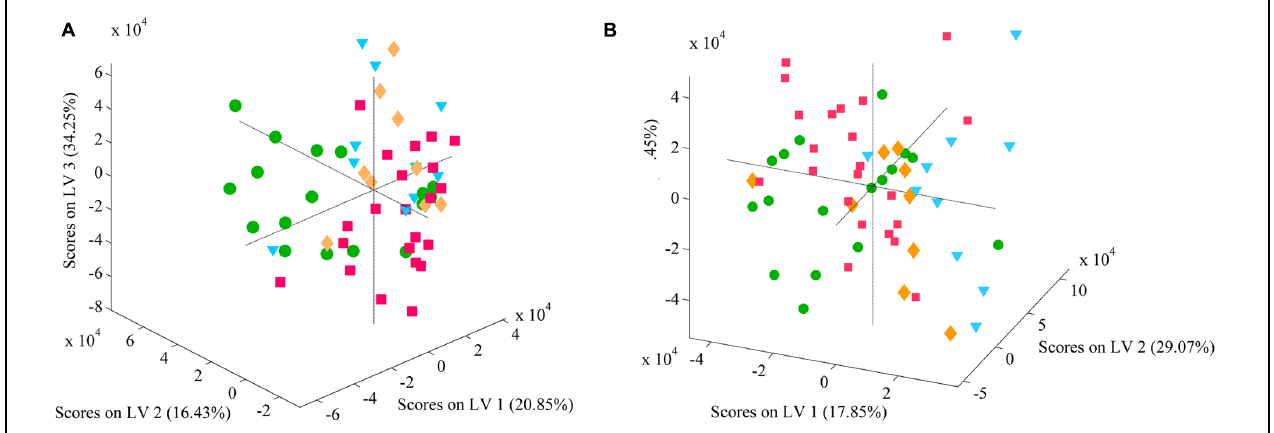
TABLE 2 | Confusion matrix for both of the A. baumannii PLSDA discrimination models, considering 20 LV (values are in %).